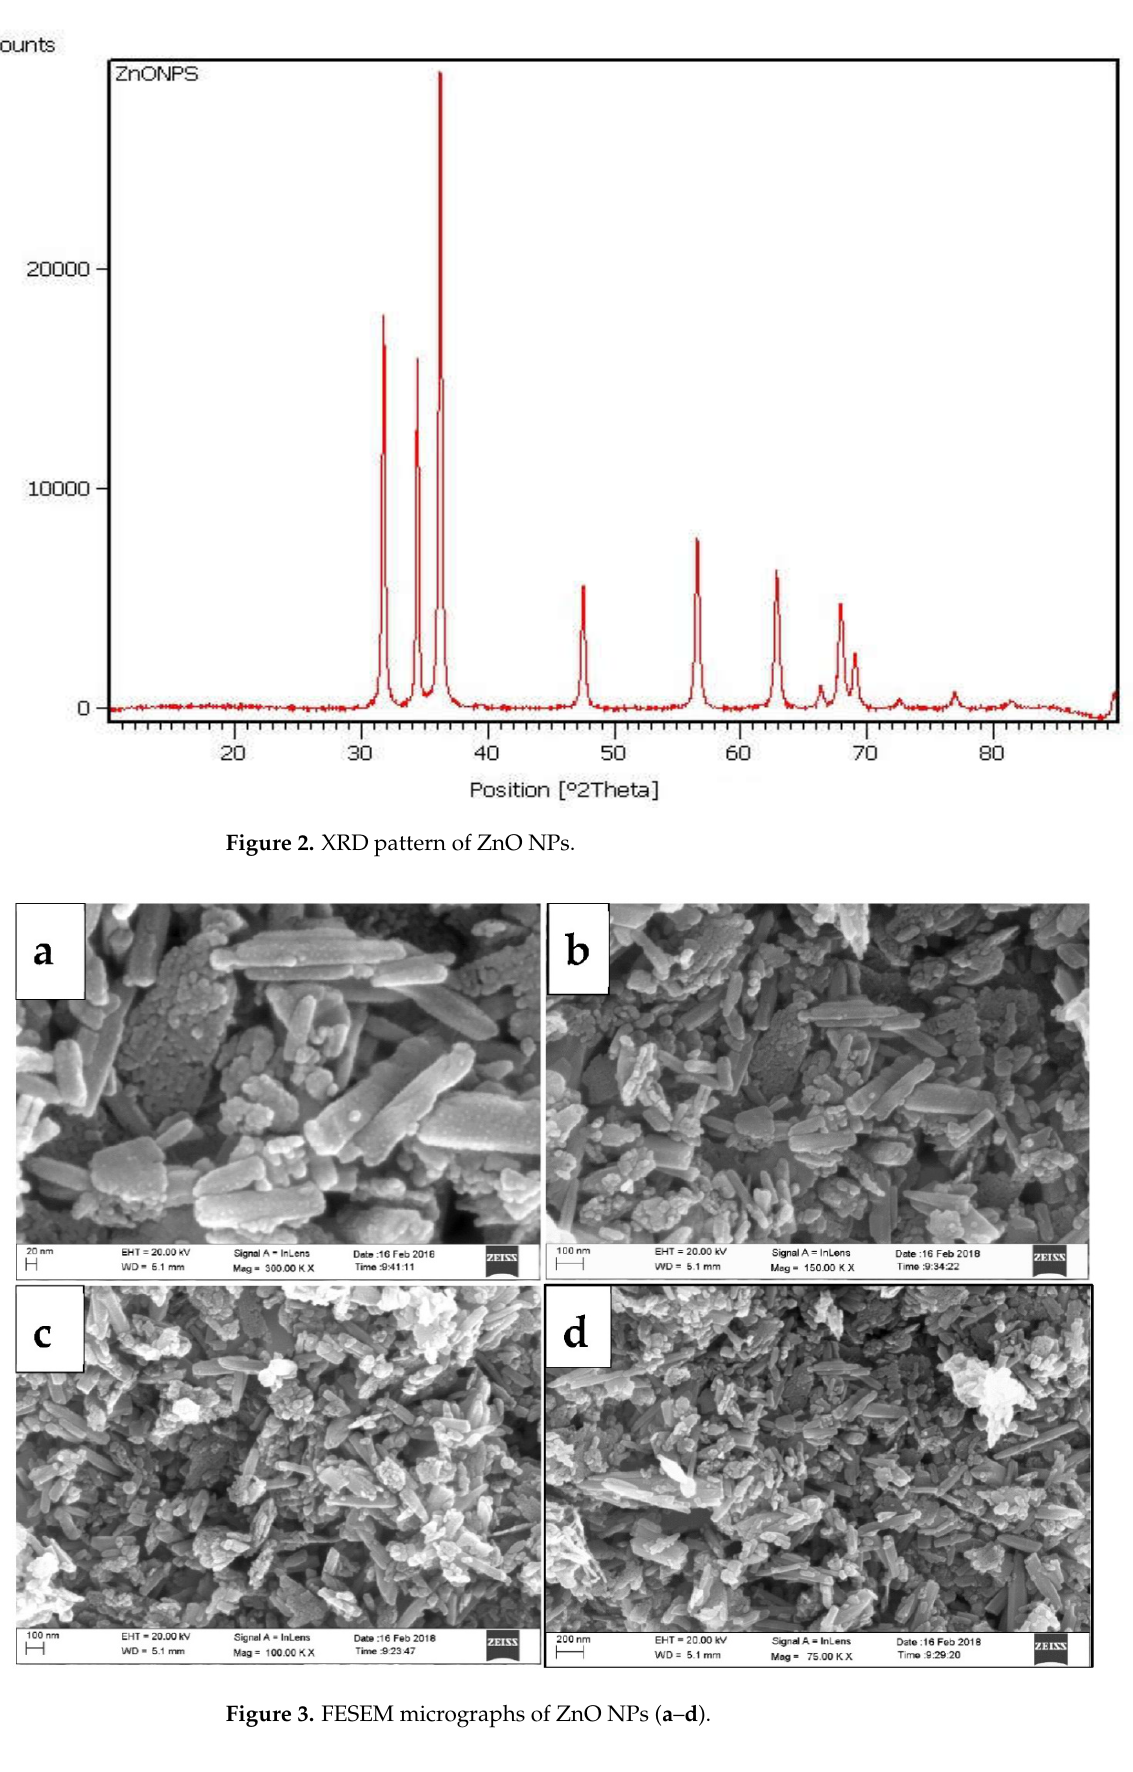
Figure 4. FTIR spectrum of ZnO NPs.